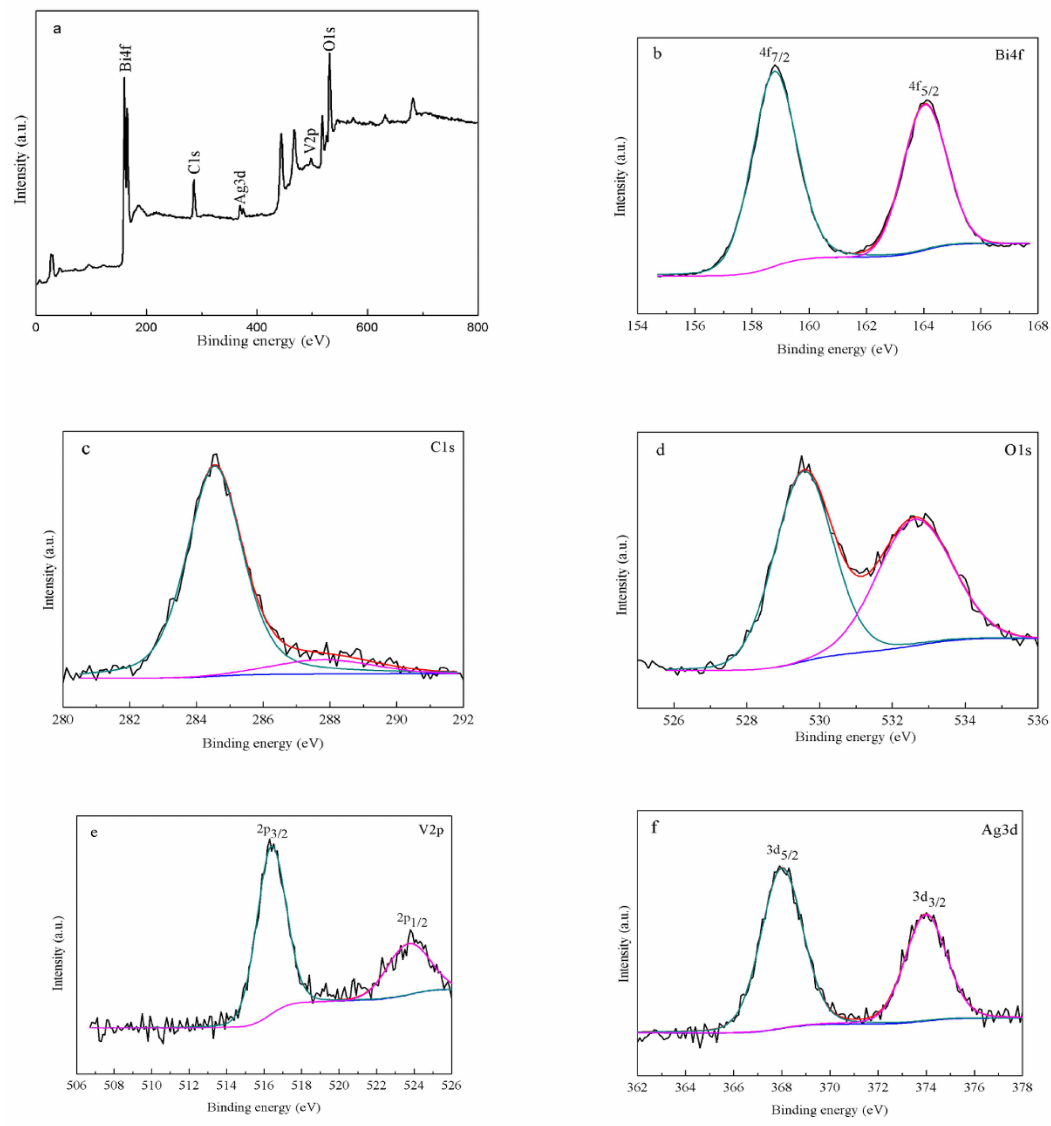
Figure 5. XPS of the as-obtained AgGB-0.5: ( a ) survey XPS spectrum; ( b ) Bi 4f spectrum; ( c ) C1s spectrum; ( d ) O1s spectrum; ( e ) V2p spectrum; and ( f ) Ag 3d